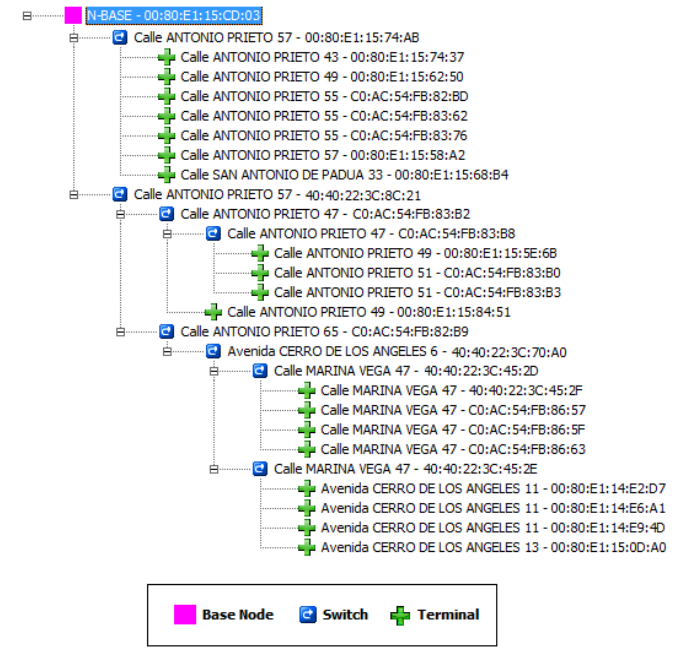
Figure 5. Power Line Communications (PLC) topology in a